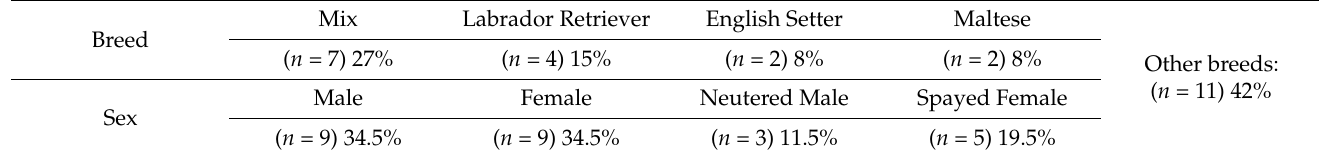
Table 1. Population data. Breed and sex.